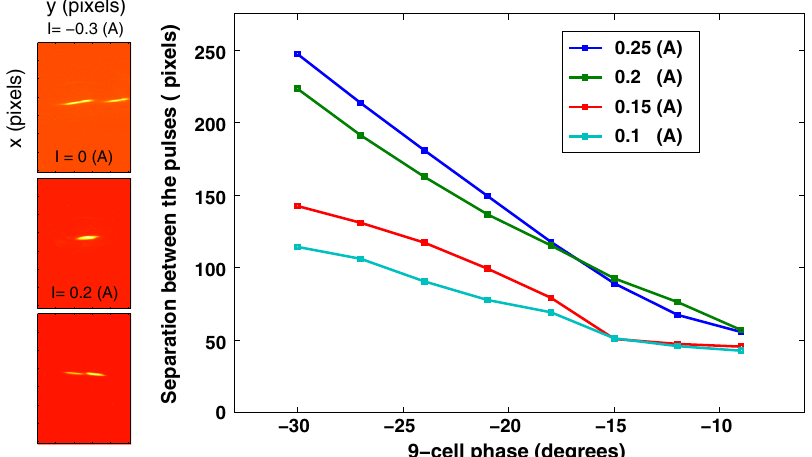
FIG. 7. The figures on the left show the transverse images of the twin pulses observed at X24 versus the skew-quadrupole current in Amps. When the skew quadrupole is turned on, the separation in pulses is observed. Each image is 520 pixels (cid:8) 710 pixels . The calibration factor is 32 : 8 microns = pixel . On the right, the separation of the pulses in pixel units are given as a function of rf chirp for every skew-quadrupole strength.